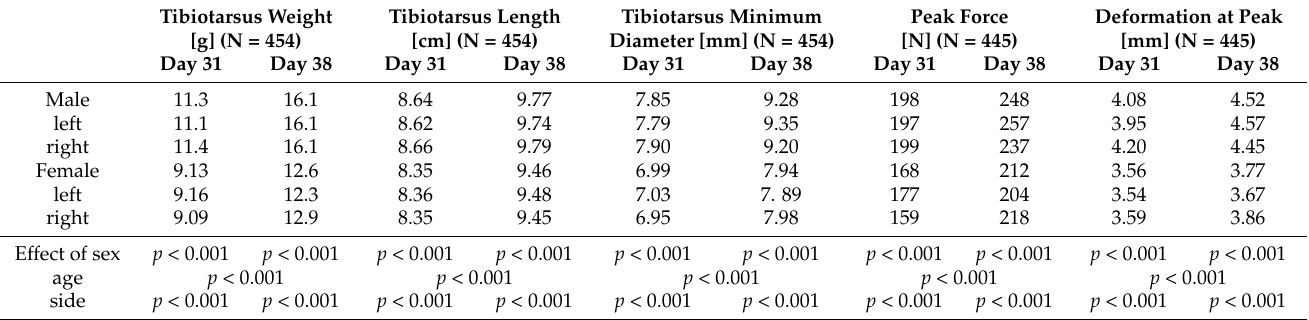
Table 4. Left and right tibiotarsus weight, length, minimum diameter, peak force and deformation at peak on day 31 and day 38 for male and female broilers.